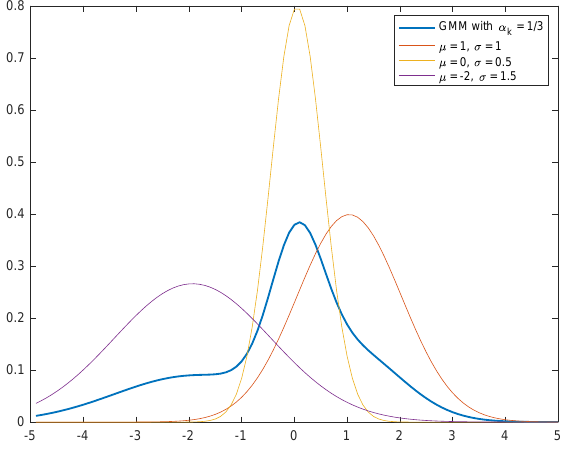
Figure 2. A Gaussian mixture